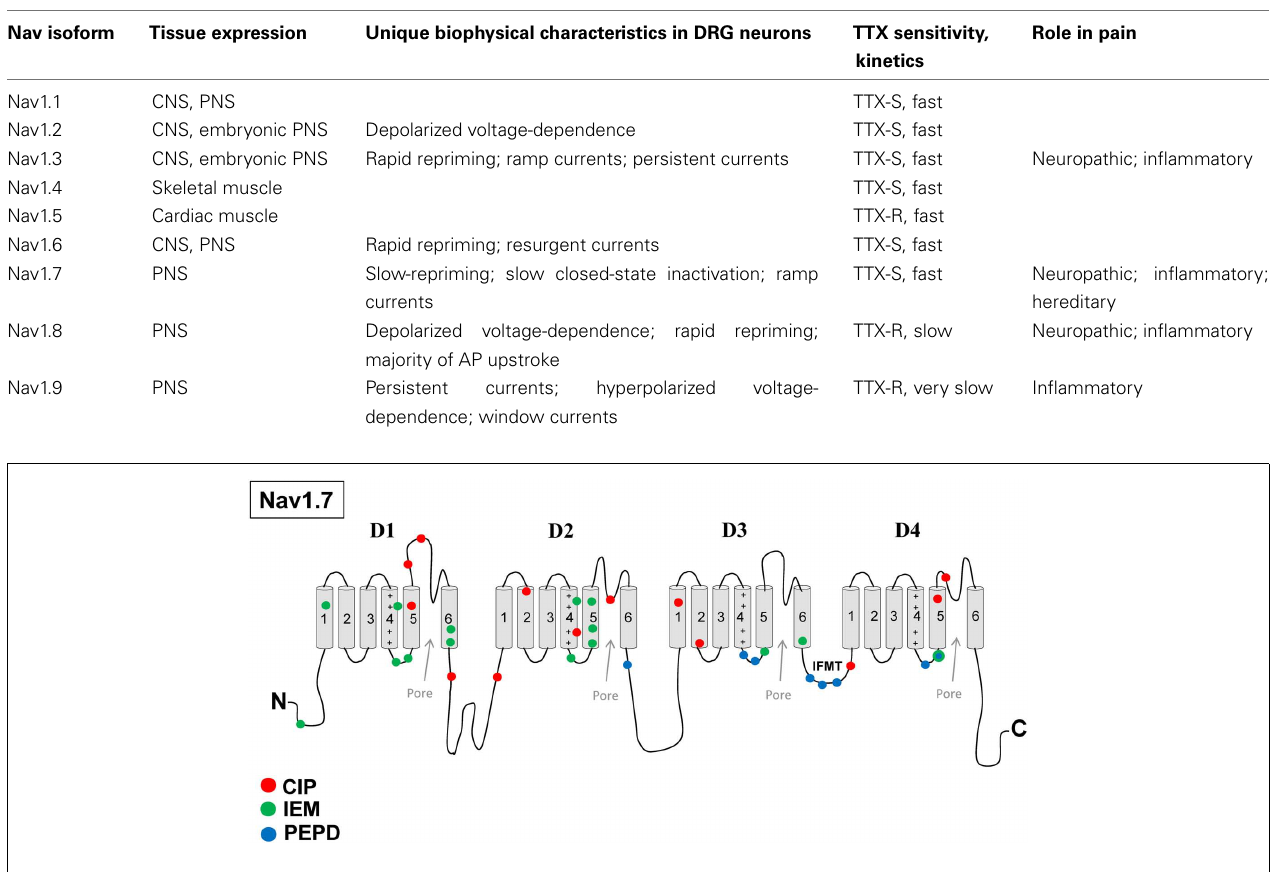
FIGURE 1 | Nav1.7 mutations associated with inherited pain syndromes. A linear representation of the Nav1.7 α -subunit showing the approximate